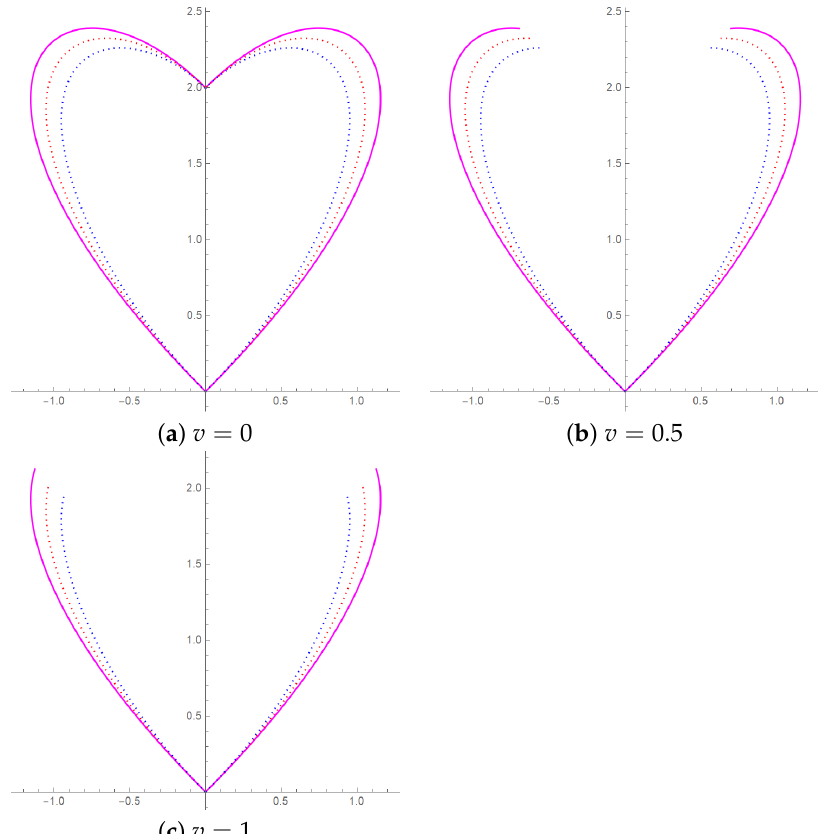
Figure 16. Modelling shape of heart using cubic fractional Bézier curve with different shape parame- ters and fractional